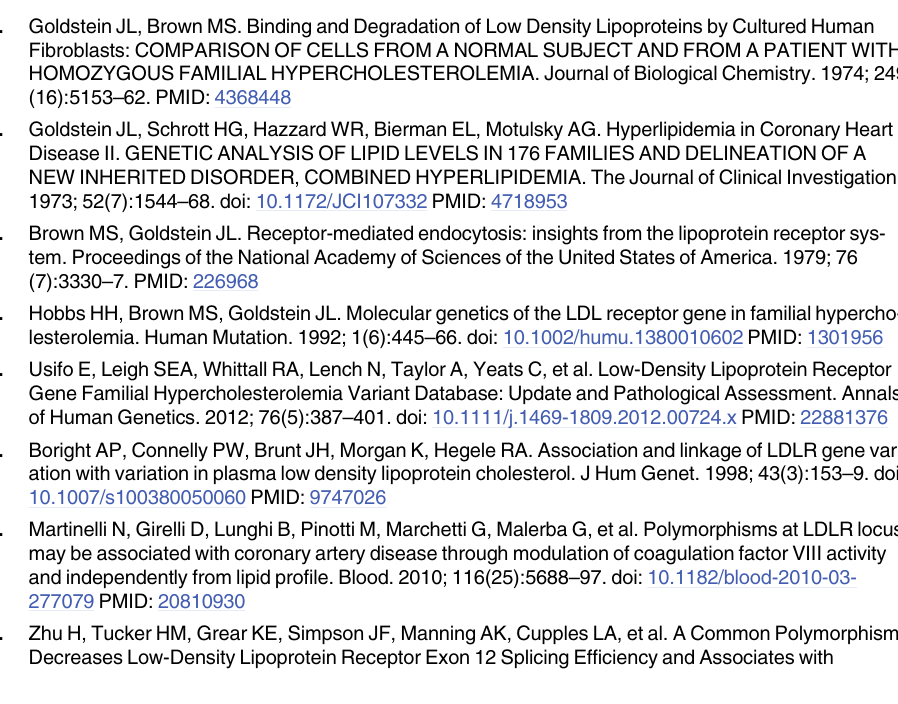
S3 Table. Predicted regulatory element and protein binding of LDLR selected SNPs. (cid:3) minor